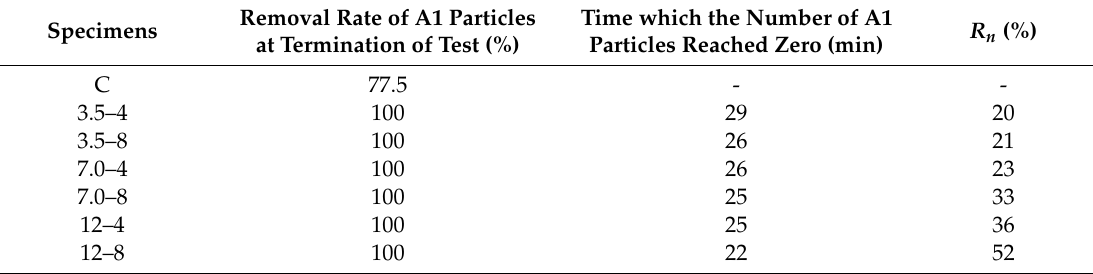
Table 4. Summary of the number of A1 particles adsorbed on the textile fabrics.